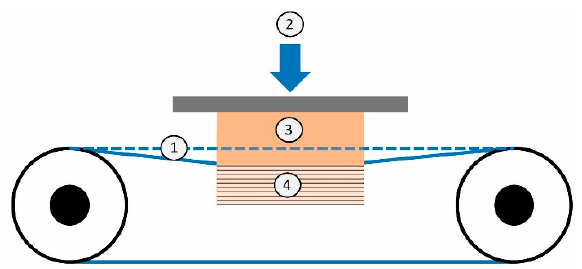
Figure 2. Wire bow (length); 2: Feed direction; 3: Compact part of the workpiece; 4: Processed part of the workpiece [6].